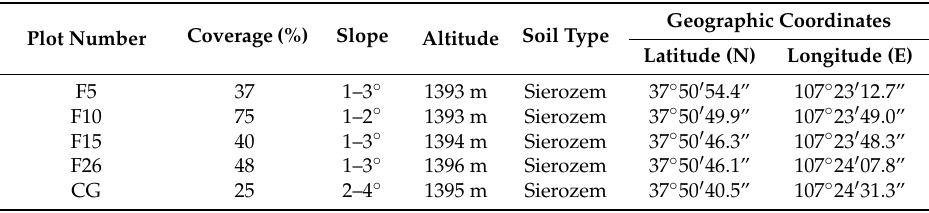
Table 1. Basic characteristics information in different plots. F5 (enclosed 5 years), F10 (enclosed